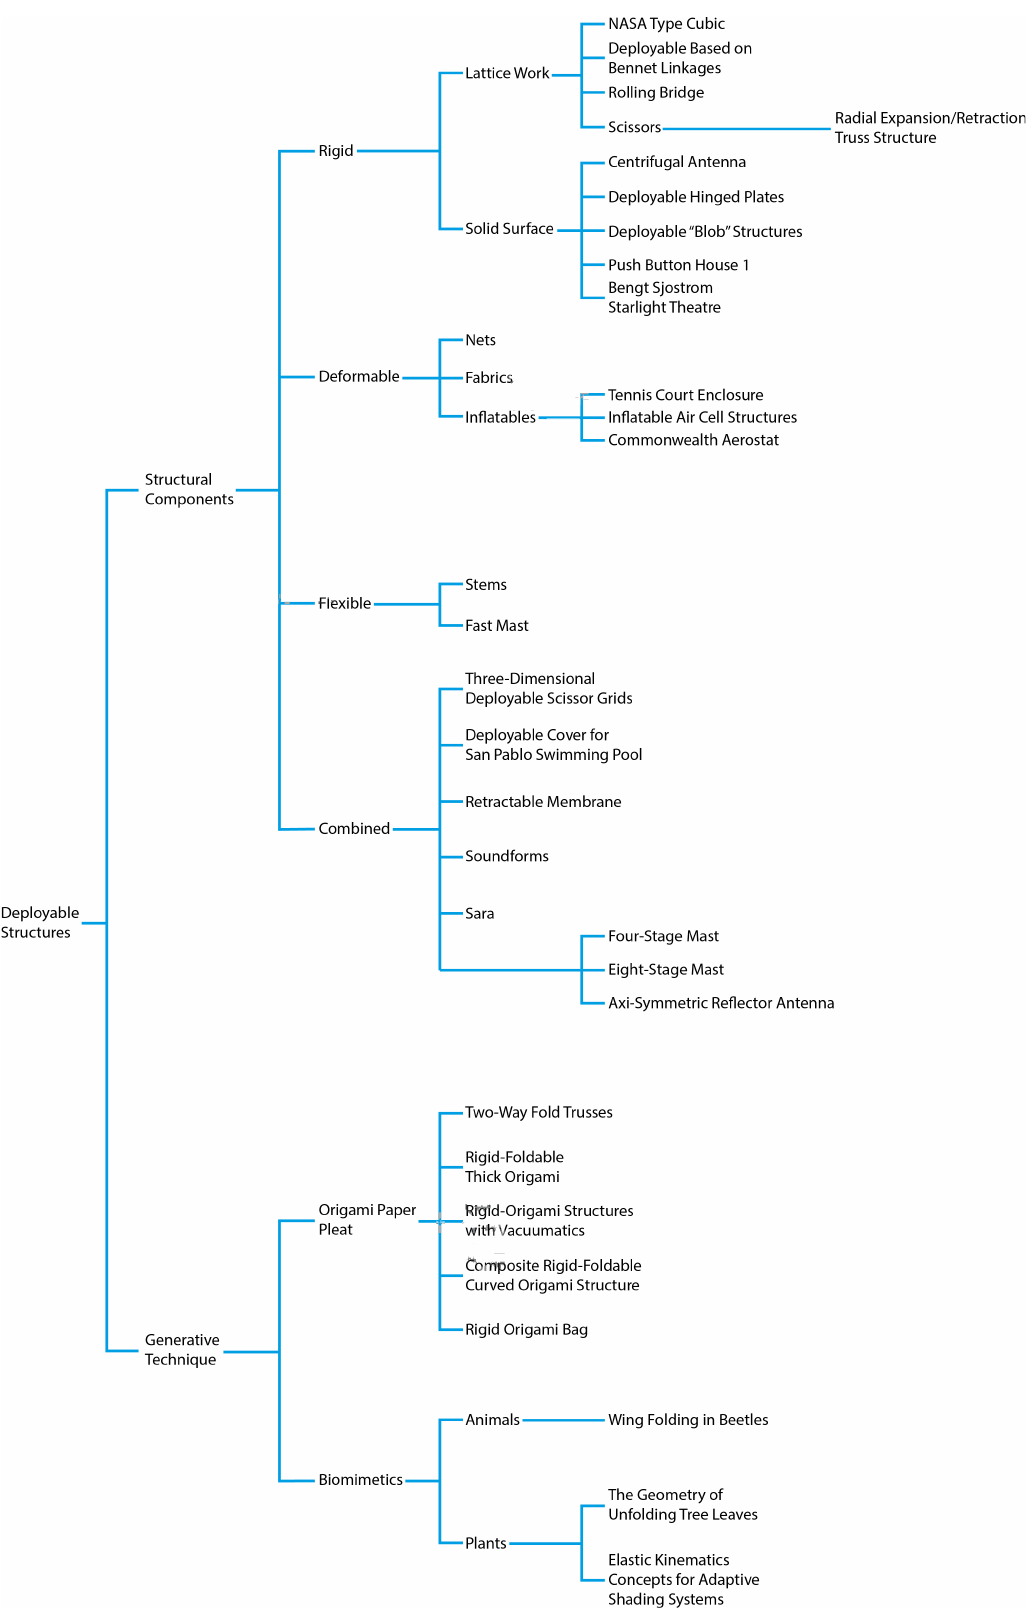
Figure 12: Classification by Rivas Adrover from